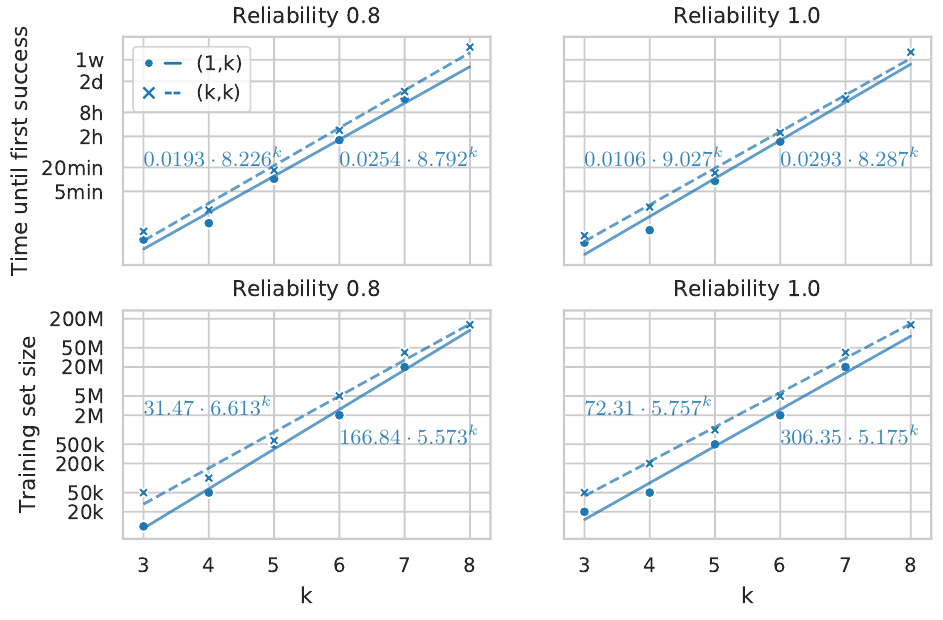
Figure 4: Attack run time and best-performing number of CRPs for Interpose PUFs of different reliability and varying number of employed arbiter chains. Interpolations given were computed using regression for a, b on a · b k using all available